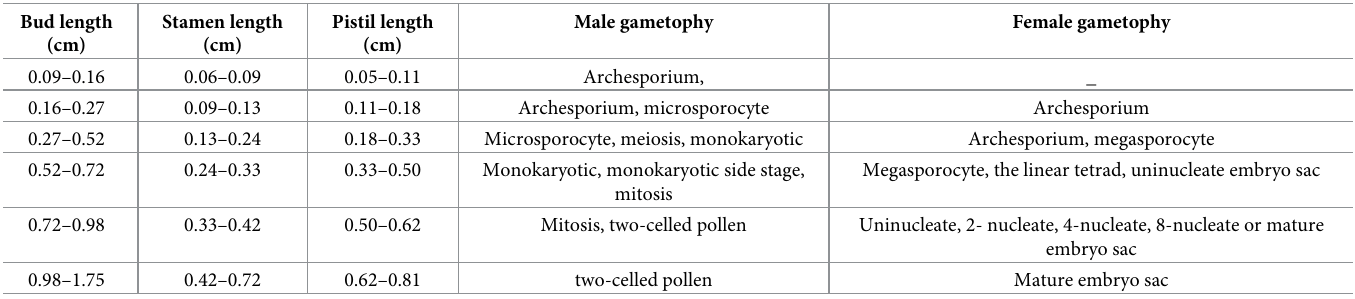
Table 2. Development relationship between gametophytes and flower bud morphology of Clematis serratifolia . Bud length